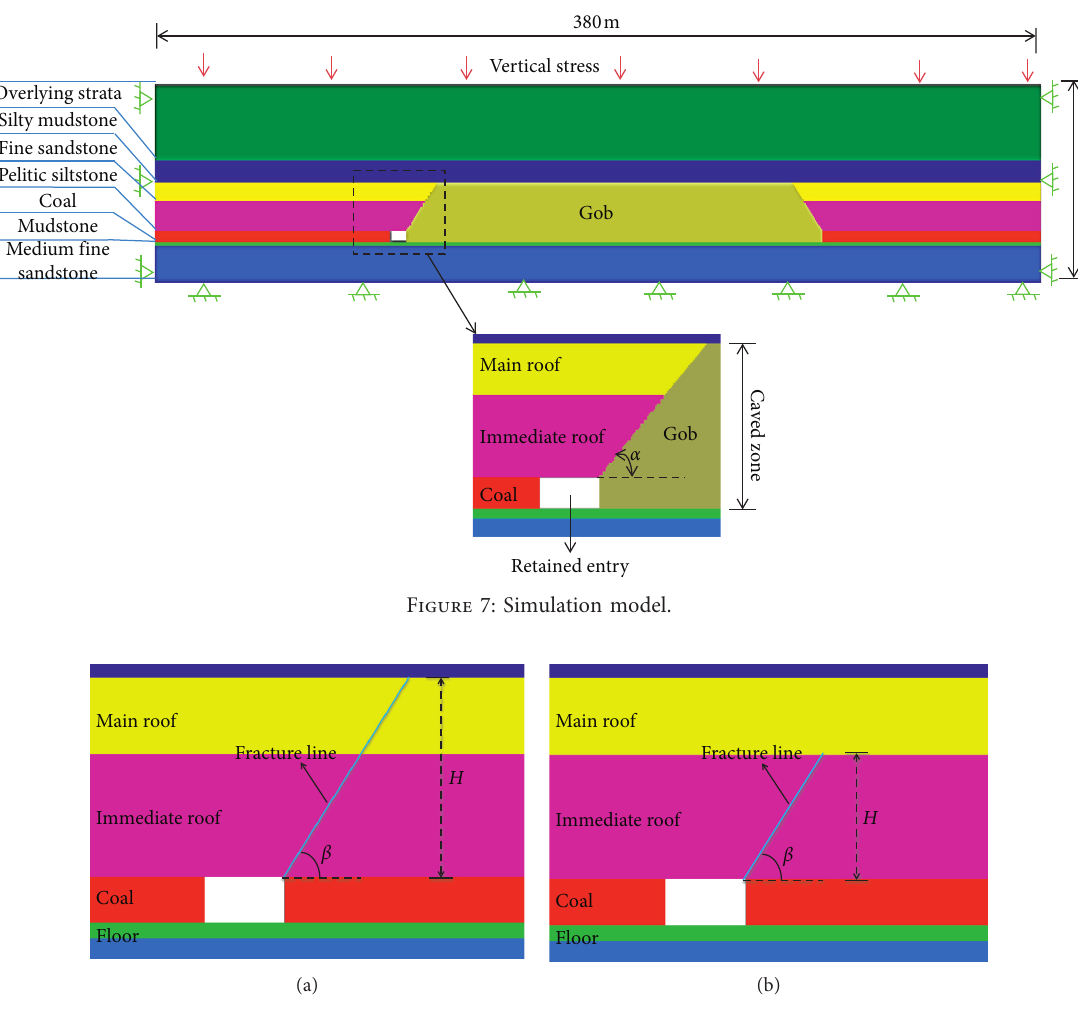
Figure 8: Simulation schemes. (a) Fracturing immediate and main roof. (b) Fracturing immediate roof. Table 3: Simulation schemes parameters.